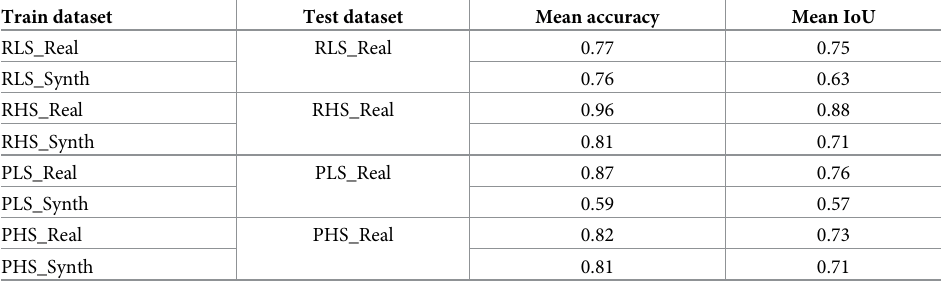
Table 5. Semantic segmentation results using only one type of the real underwater sonar image datasets and syn- thetic underwater sonar image datasets. Train